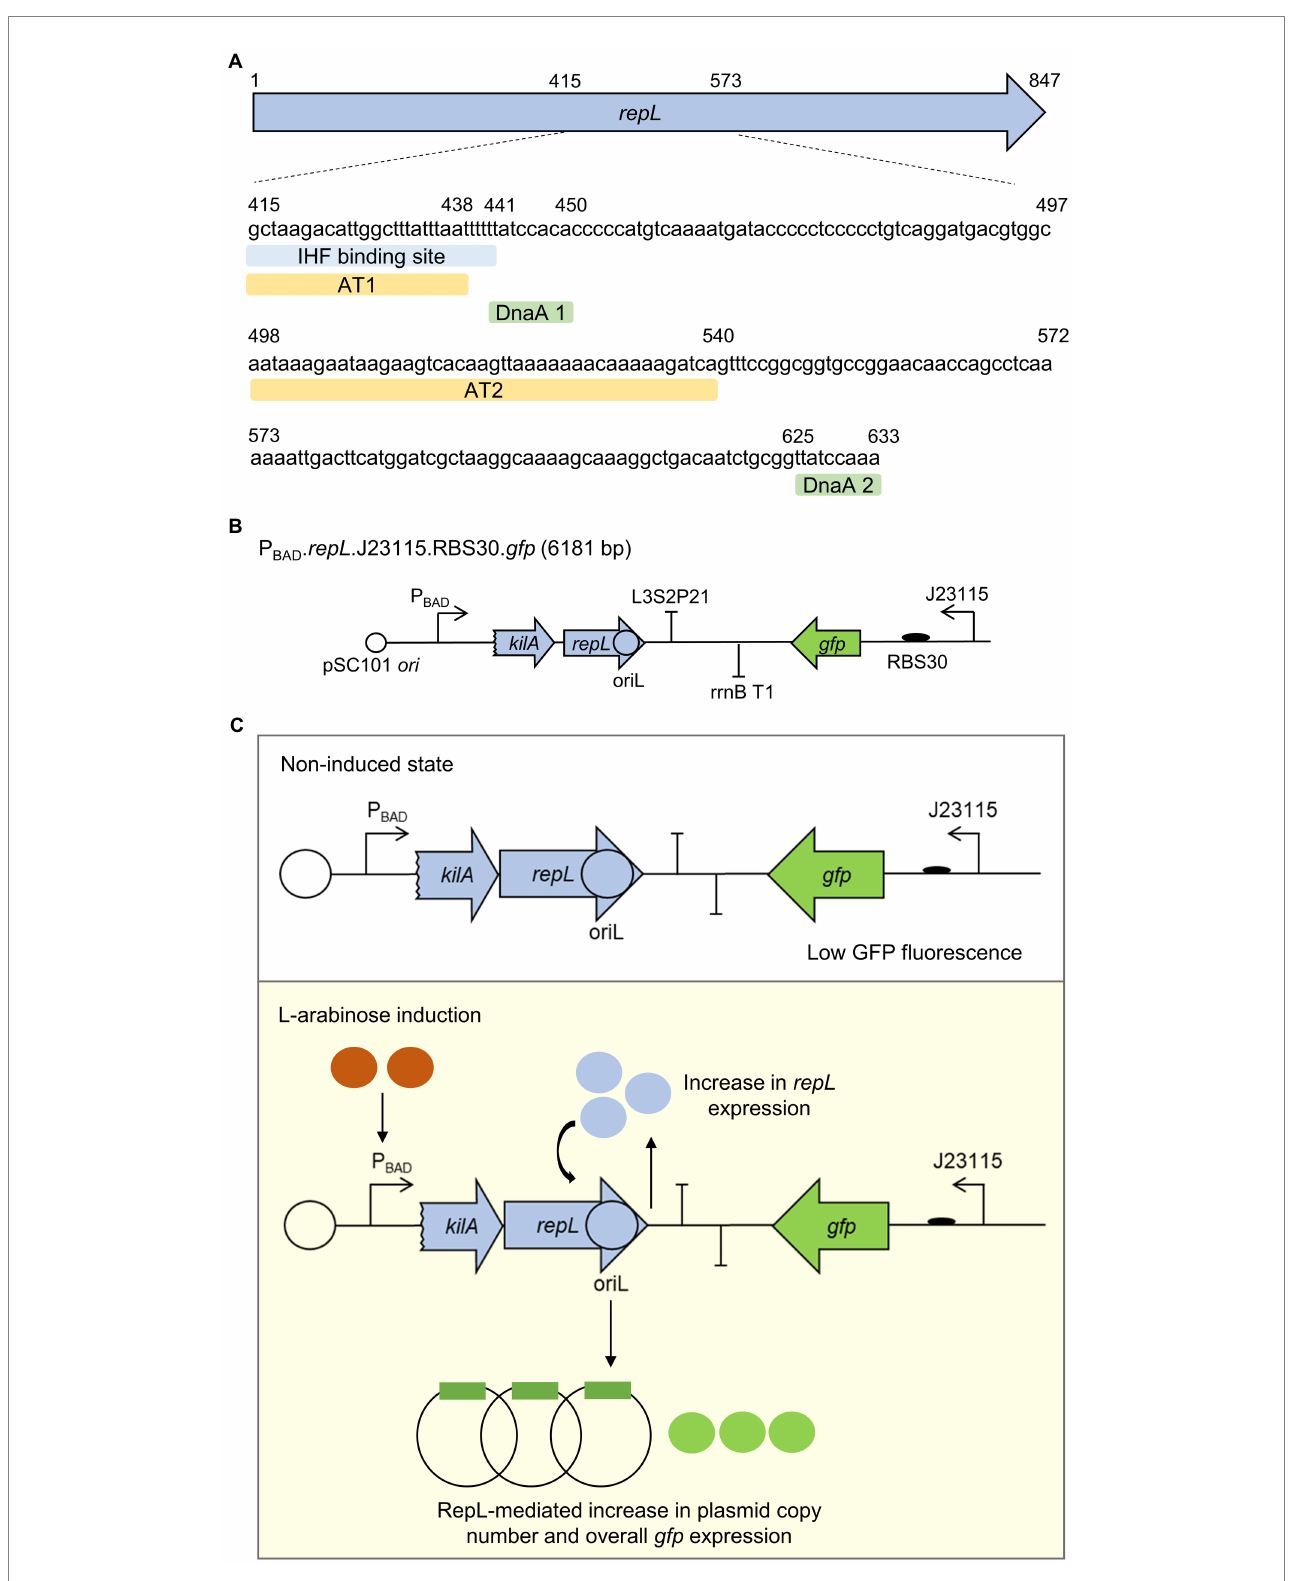
FIGURE 1 A gfp reporter plasmid to assess the RepL-mediated DNA replication process in E. coli . (A) The location (nucleotide positions relative to repL open reading frame, first nucleotide and last nucleotide of AT1, AT2, DnaA binding sites 1 and 2 were shown as numbers) and sequences of A/T-rich regions 1 and 2 (AT1, AT2, light orange), IHF binding site (light blue), DnaA binding sites 1 and 2 (DnaA 1, DnaA 2, light green) within the second half of repL gene (light blue arrow). The location of these DNA elements in relation to the full length repL coding sequence was shown in Supplementary Figure 1. (B) Schematic diagram of a gfp.repL reporter construct. repL (light blue arrow) gene expression was controlled by the arabinose-inducible promoter P BAD . A 24 bp coding sequence of kilA was included, as this provides the native ribosomal binding site (RBS) for repL translation (Sheth et al., 2017). oriL, the lytic stage origin